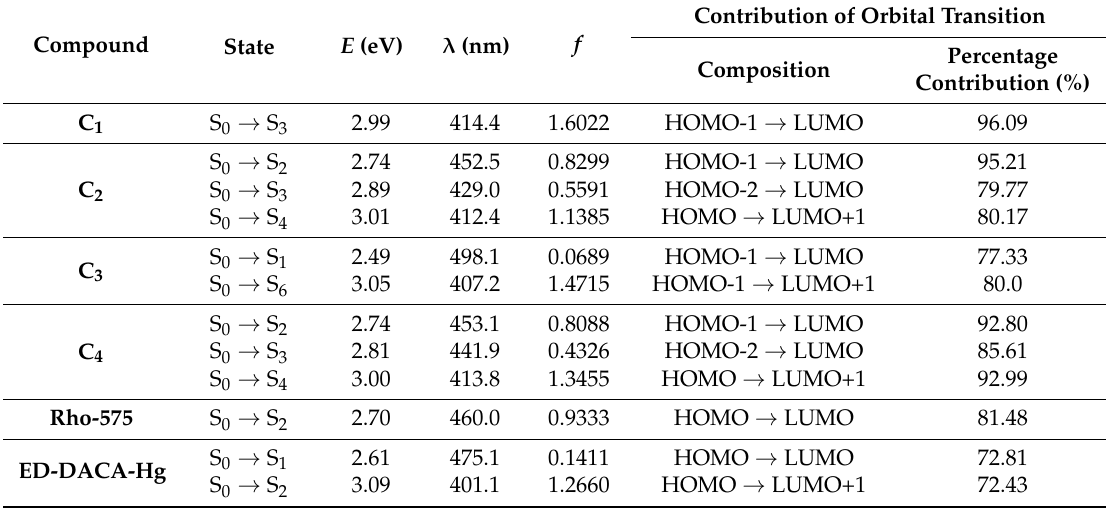
Table 2. The calculated excitation energy (E), wavelength ( λ ), and oscillator strength ( f ) for